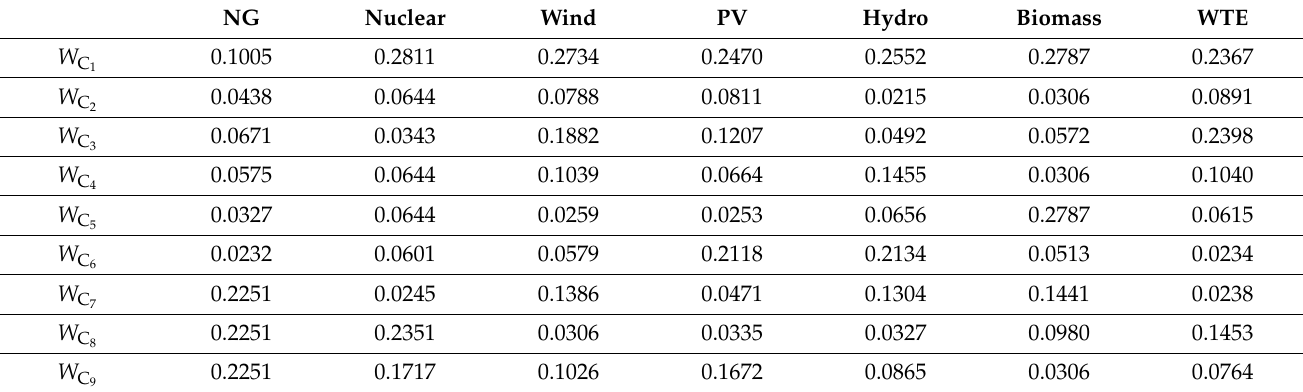
Table 3. Weight of criteria for energy power plants.